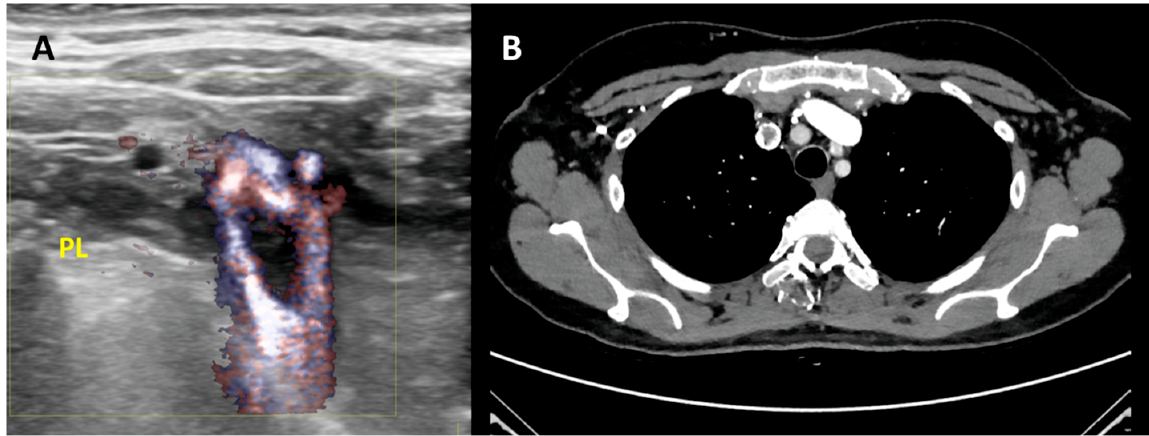
Figure 3. Second level diagnosis of IJVthr. ( A ) Case of right IJVthr with a floating thrombus approaching the superior vena cava; high resolution ultrasound complemented by B-flow enhances the black floating thrombus. PL = pleural line. ( B ) Same case demonstrated by angio-TC.